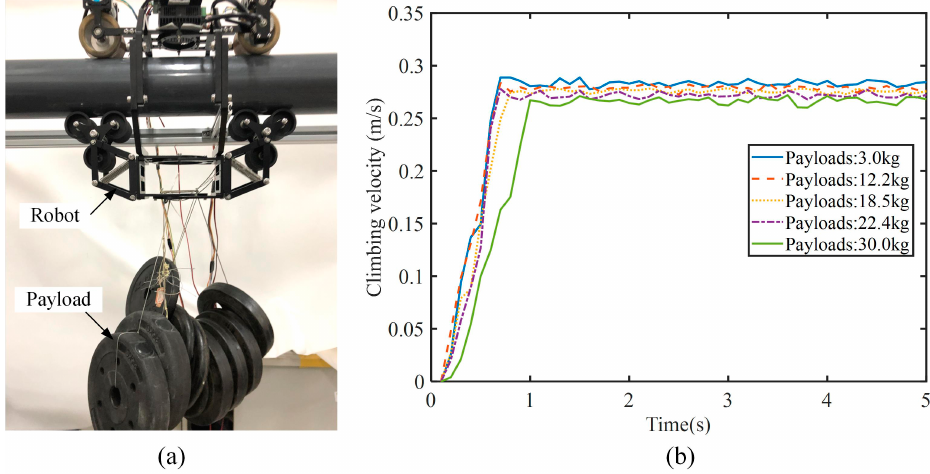
Figure 15. Payload experiments of the pipeline-climbing robot: ( a ) Robot and Payloads; ( b ) Robot climbing velocities with different payloads.